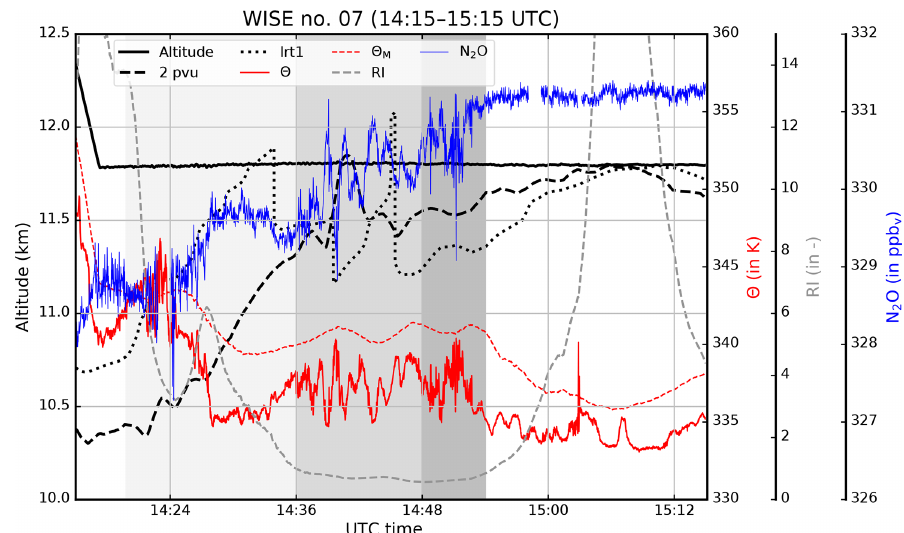
Figure 4. Time series of measured N 2 O (blue) and potential temperature (cid:50) (red solid) as well as modeled potential temperature (cid:50) M (red dashed), Richardson number Ri (gray dashed), and altitudes of the dynamic (2pvu, black dashed) and the first lapse rate (lrt1, black dotted) tropopause between 14:15 and 15:15UTC during WISE RF07. Black solid line shows the altitude of the aircraft, the gray areas indicate the time periods discussed in the